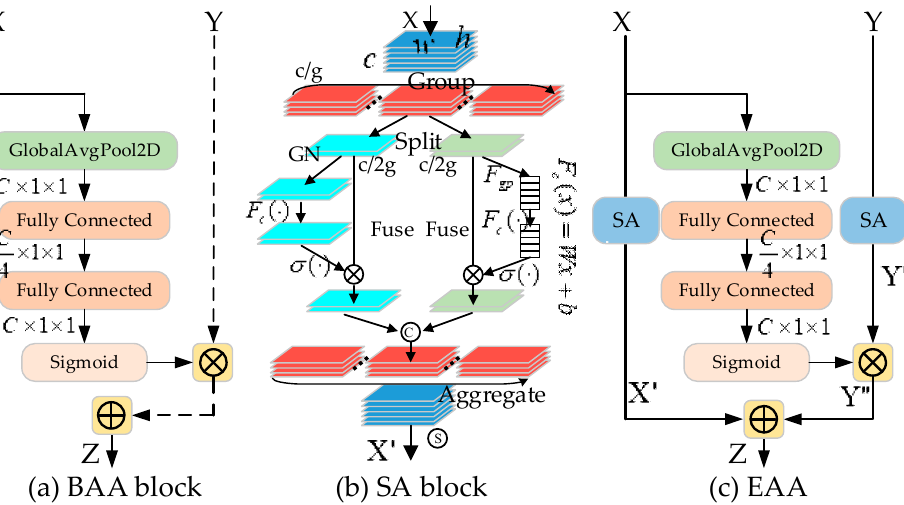
Figure 3. The proposed modules. ( a ) Cross-layer bottom-up asymmetric attention (BAA) block. ( b ) Shuffle attention (SA) block. ( c ) Enhanced asymmetric attention (EAA) module. ⊗ , ©, ○ S and σ ( ⋅ ) denote element-wise product, concat, channel shuffle, and sigmoid, respectively.